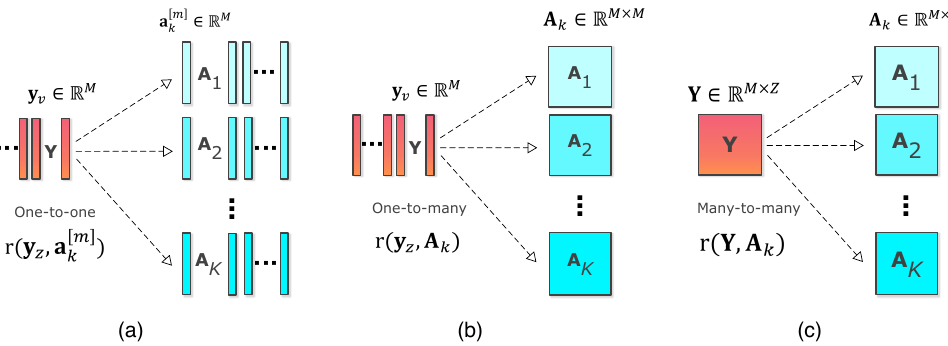
Figure 1. Three different ways to identify associations between imaging and behavioral features using ( a ) one-to-one, ( b ) one-to-many, and ( c ) many-to-many association techniques. Here, r ( · , · ) is the function that denotes the association between the profiles and behavioral